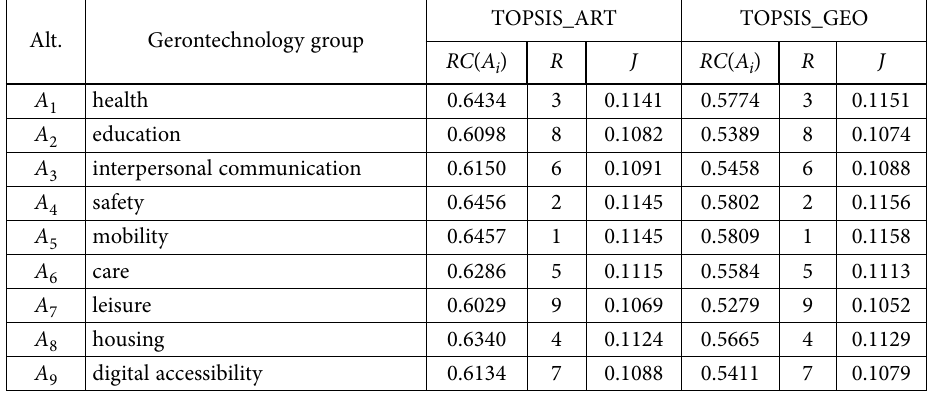
Table 4. Rankings of gerontechnologies with the use of TOPSIS_ART and TOPSIS_GEO